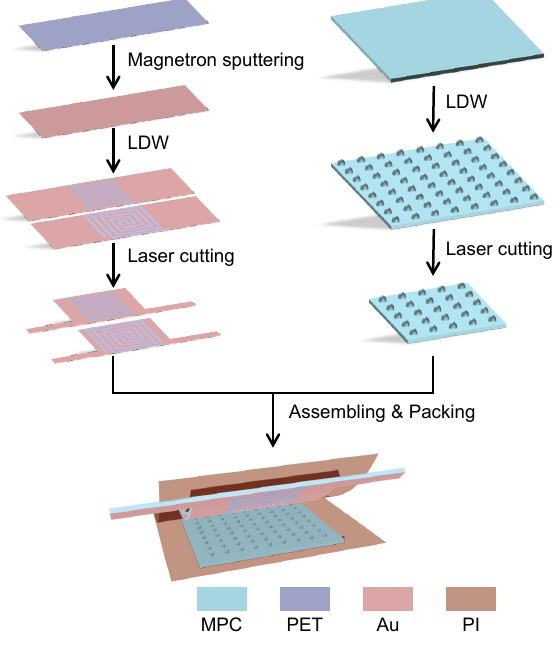
Fig. 1 | Design and fabrication of flexible piezoresistive sensor.